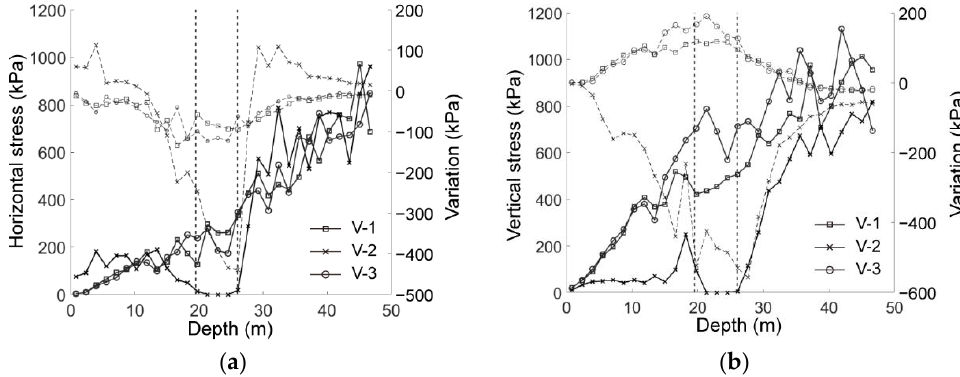
Figure 9. The stress state of the ground after excavation: ( a ) distribution of horizontal stress, σ xx , (solid line) and its variation (dashed line); ( b ) distribution of vertical stress, σ yy , (solid line) and its variation (dashed line). The two vertical dashed lines represented the range of the tunnel.